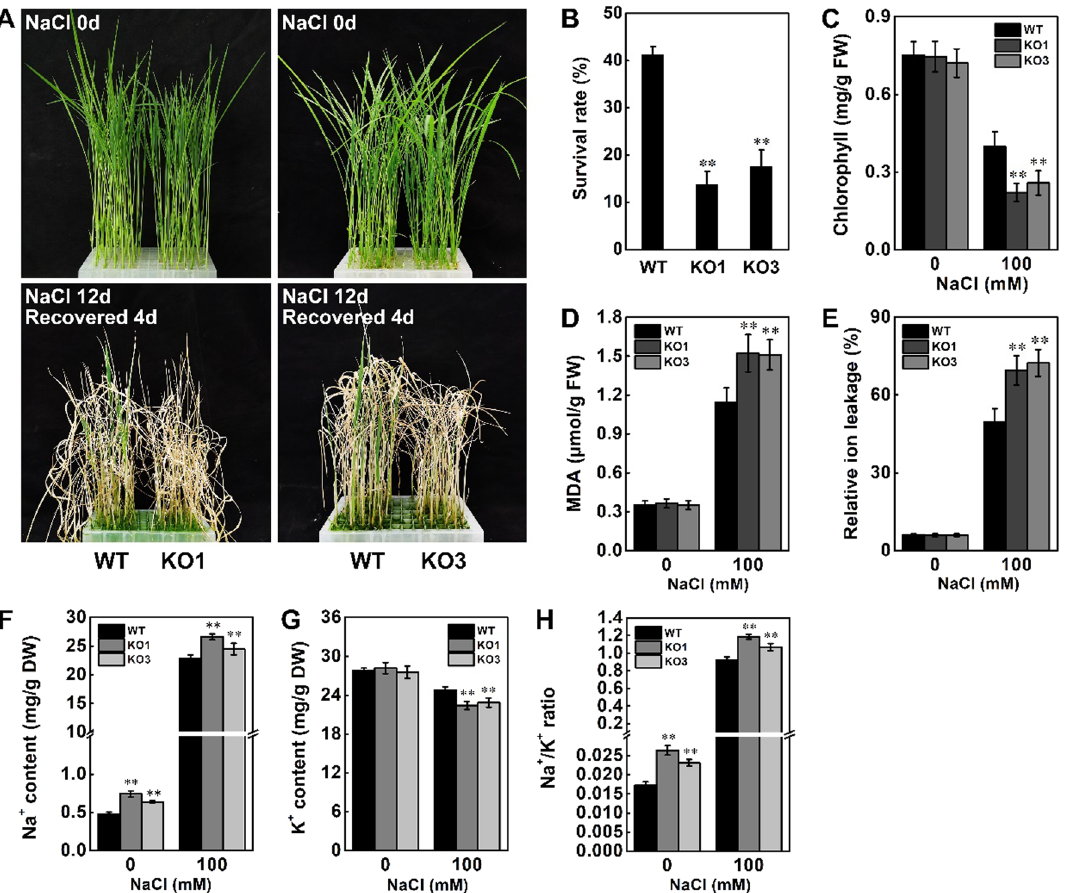
Fig. 4 Knockout of STK increased salt sensitivity in rice. A Phenotype of WT, KO1 and KO3 rice plants under salt stress at seedling stage. For STK -KO plants, 15-d-old seedlings were treated with 140 mM NaCl for 12 d and recovery 4 d. B Survival rates of WT, KO1 and KO3 in (A) after 4 d of recovery. C Chlorophyll content in leaves of 15-d-old plants treated with 100 mM NaCl for 7 d. D MDA concentrations in leaves of 15-d-old plants after 100 mM NaCl treatment for 24 h. E Relative ion leakage in leaves of 15-d-old plants after 100 mM NaCl treatment for 24 h. F – H Ion content in shoots of 4-week-old plants after 6 d of salt stress (100 mM NaCl). Wild type and STK -KO plants were exposed to salt stress (100 mM NaCl) for 6 d and the shoots were harvested for analysis of ion content. The Na + and K. + contents in seedlings were detected as previously described (Schmidt et al. 2013). Data in (B) to (H) are presented as mean SD (n 3, ** P 0.01, Tukey’s ± = ≤